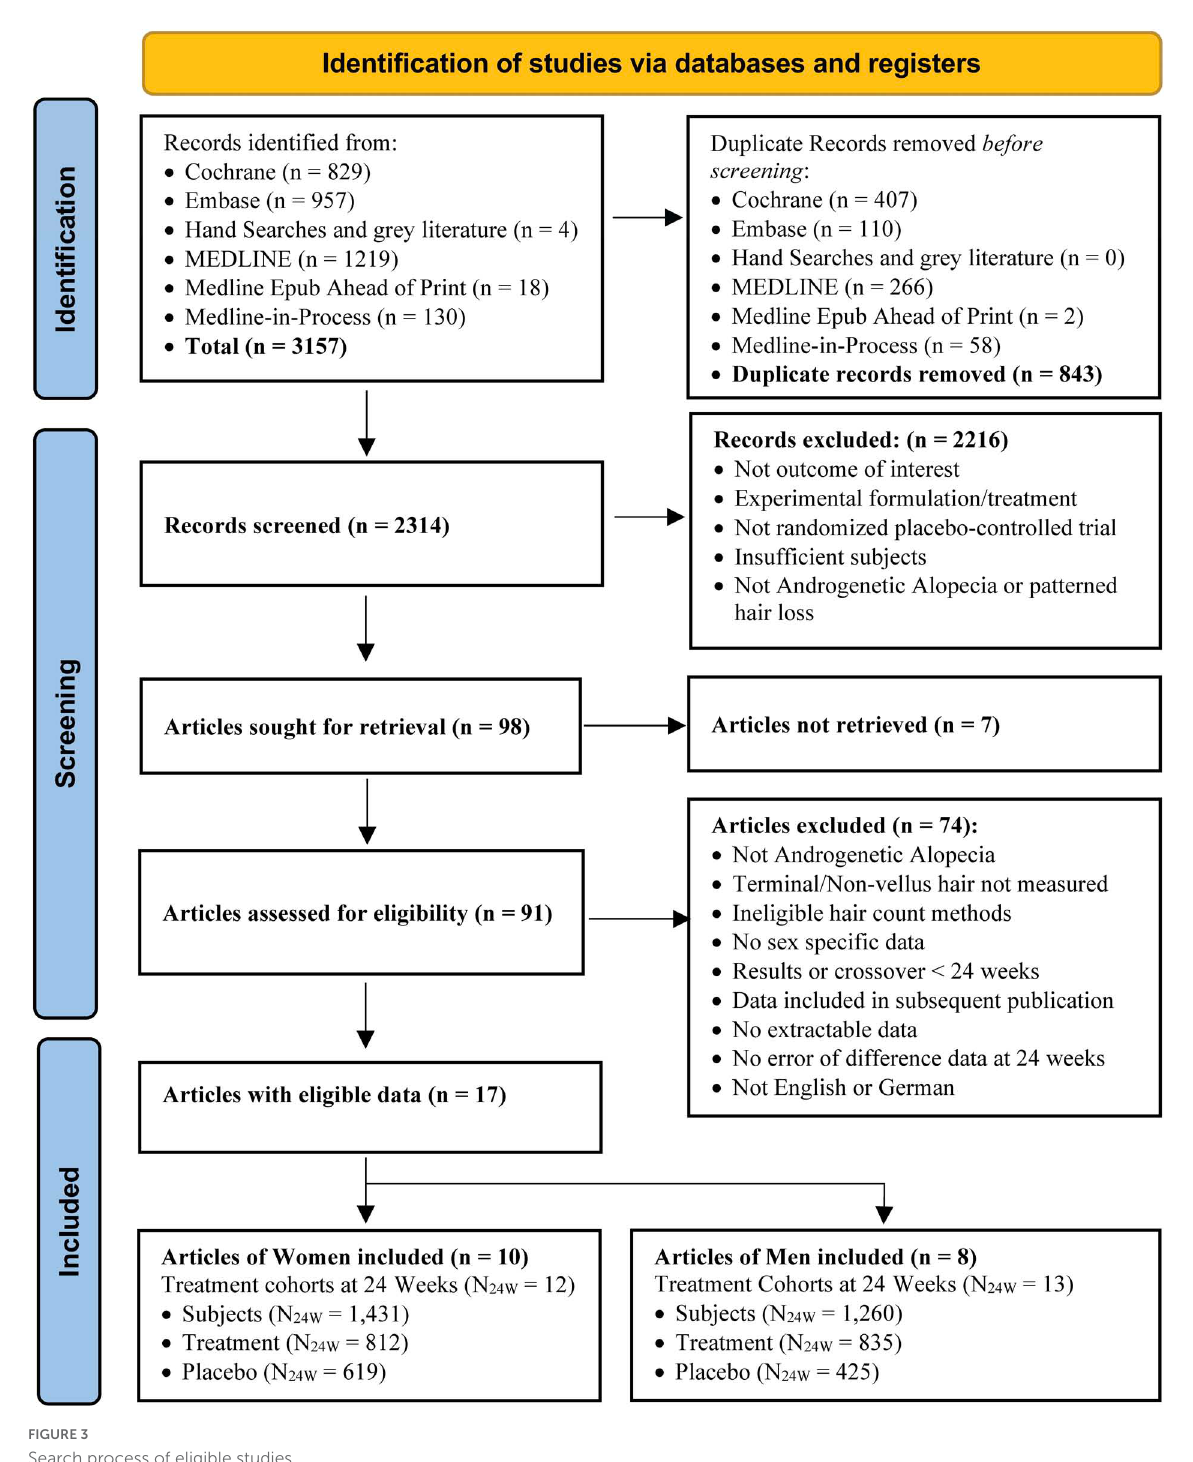
FIGURE3 Search process of eligible studies.